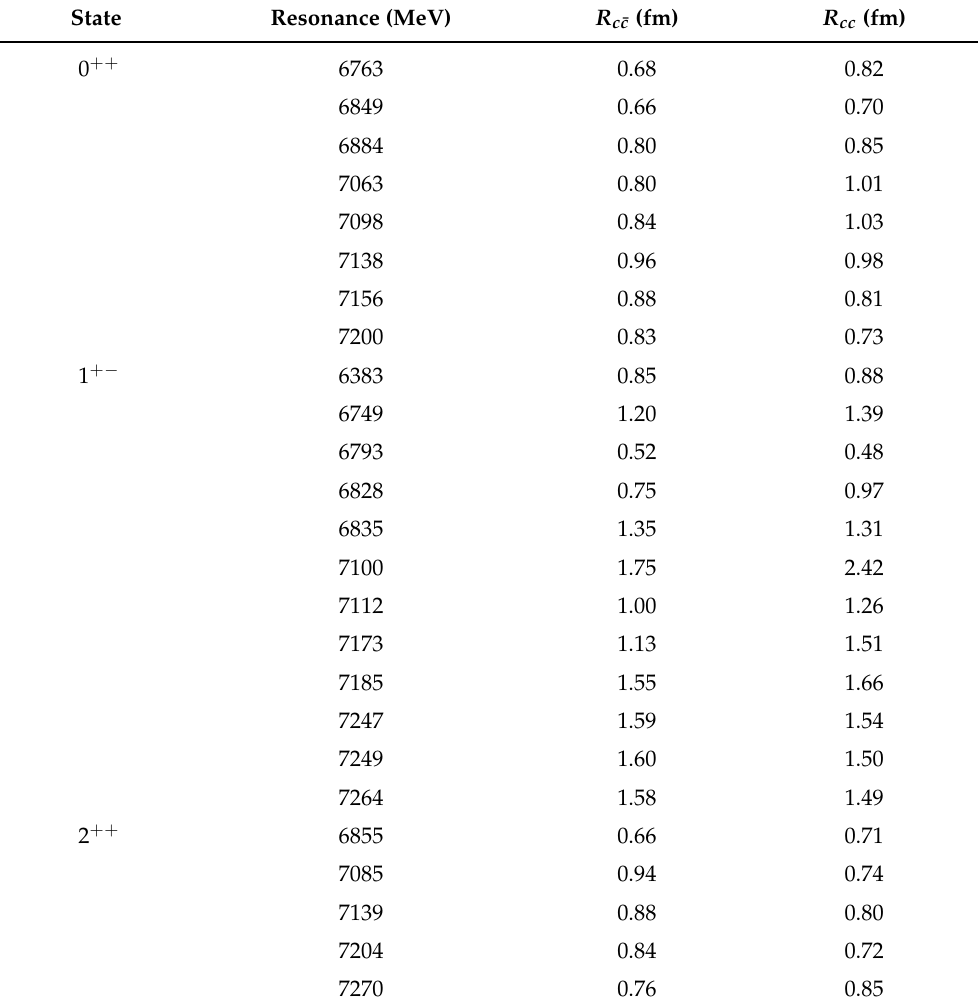
Table 7. The distances between c and c ( ¯ c ) quark for the possible resonance states of the cc ¯ c ¯ c